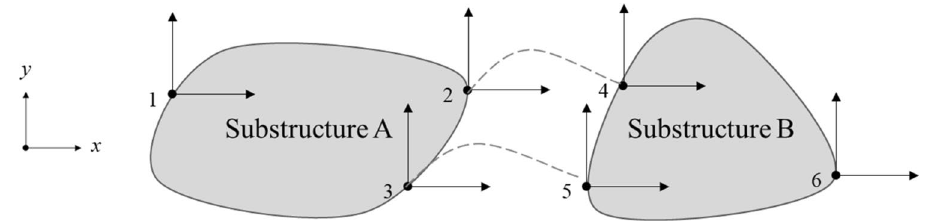
Figure 1. The system consisting of substructures A and